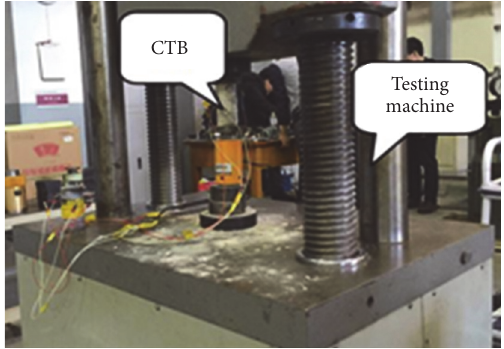
Figure 3: Equipment of uniaxial compressive